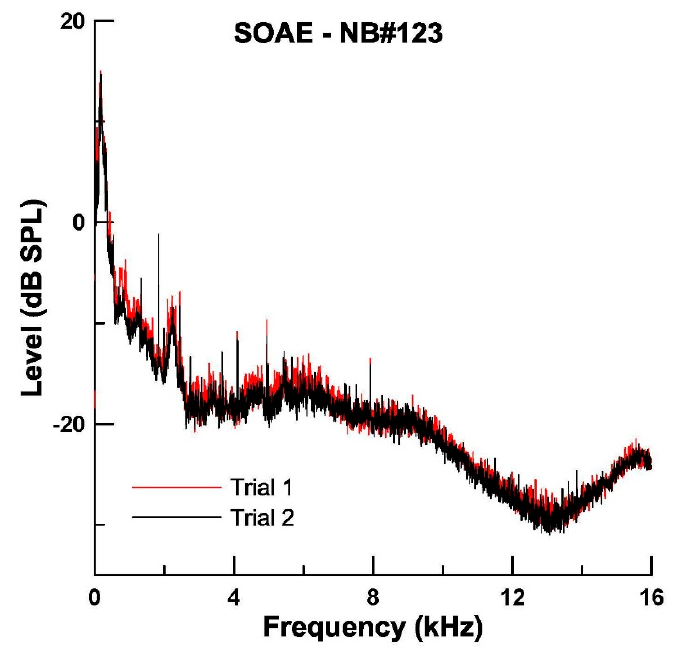
Figure 5. An example of spontaneous otoacoustic emissions (SOAEs) across frequency recorded from one newborn. There were 10 repeatable SOAEs identified for this newborn. Trial 1 is shown in red and trial 2 is shown in black.